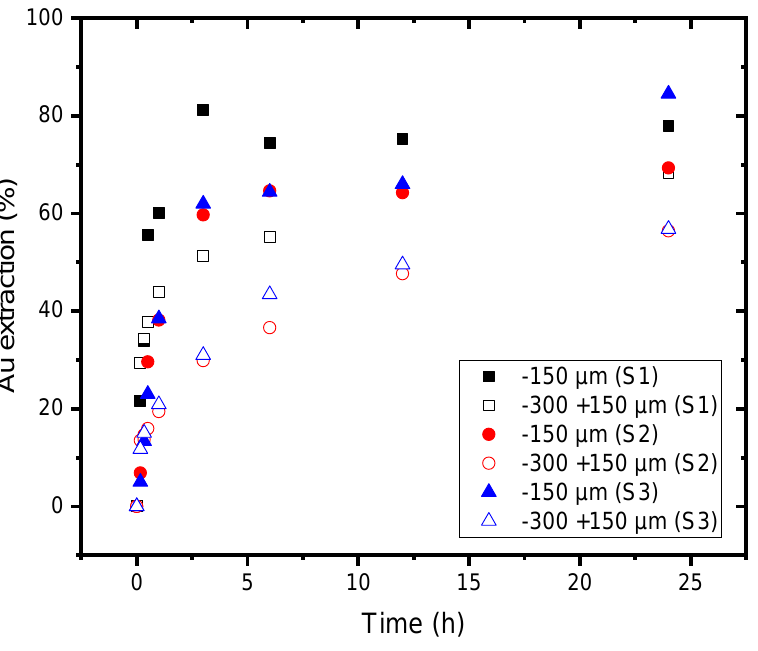
Figure 11. Au leaching at −150 µm vs. −300 + 150 µm for Sample 1 (S1), Sample 2 (S2), and Sample 3 (S3) (1 g/L NaCN, 30% solids, 300 rpm, 26 °C).